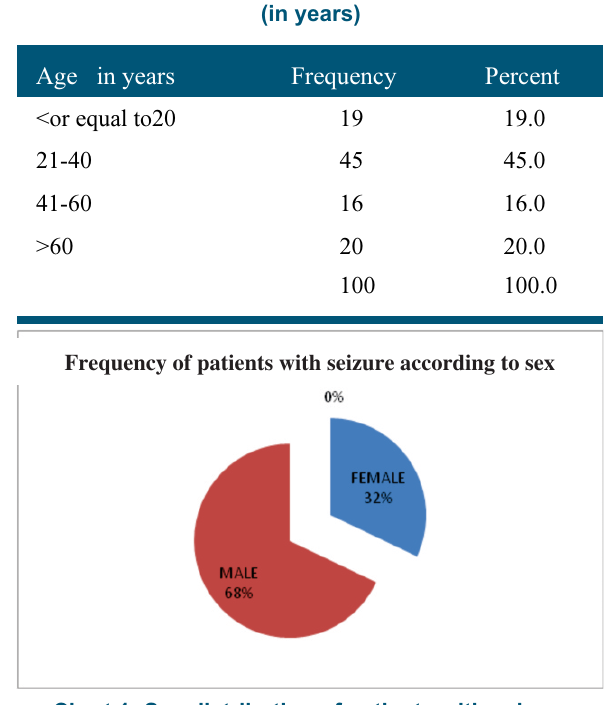
Table 1: Frequency of seizure in different age group